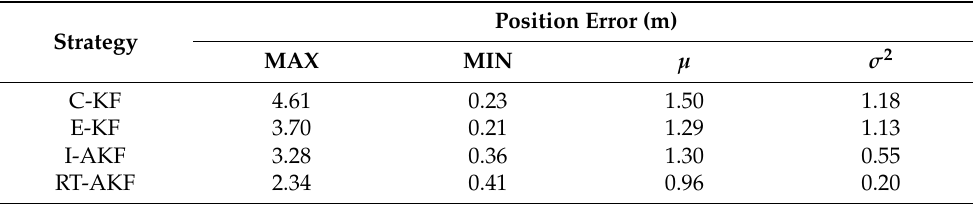
Table 7. Position Error Comparison Using Different Algorithm in Segment #5.